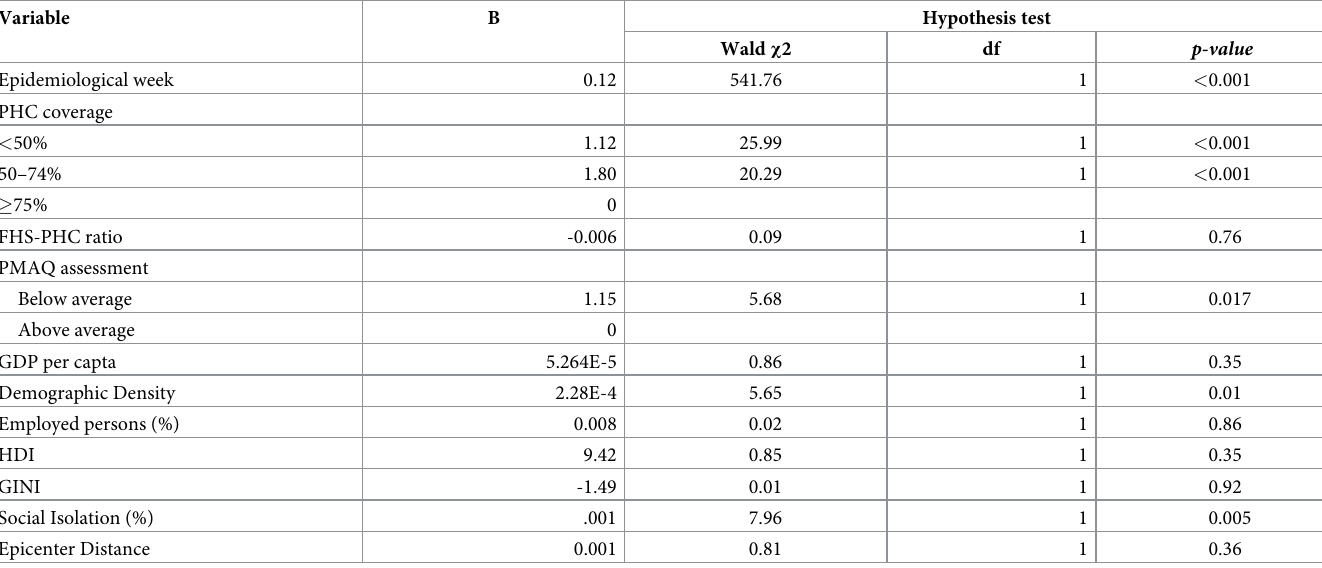
Table 2. Crude model for association with incident COVID-19 cases in the time-series of twenty epidemiological weeks in Northeastern cities in